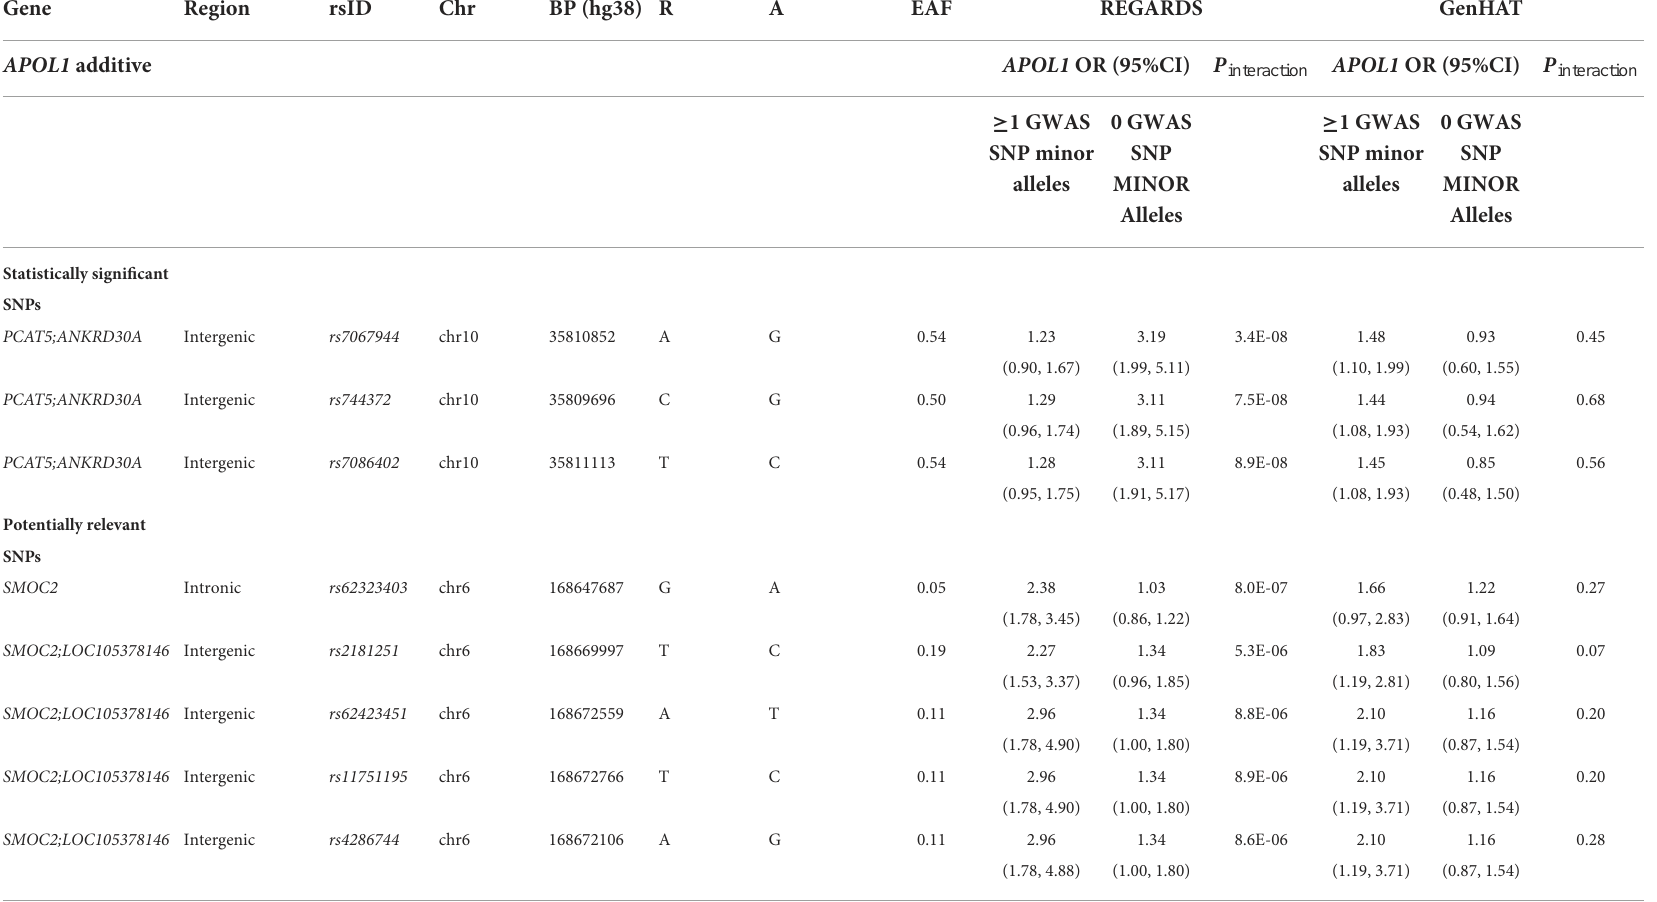
TABLE 2 Top APOL1–SNP interaction effects on ESKD in the REGARDS and GenHAT studies under APOL1 additive model. Gene